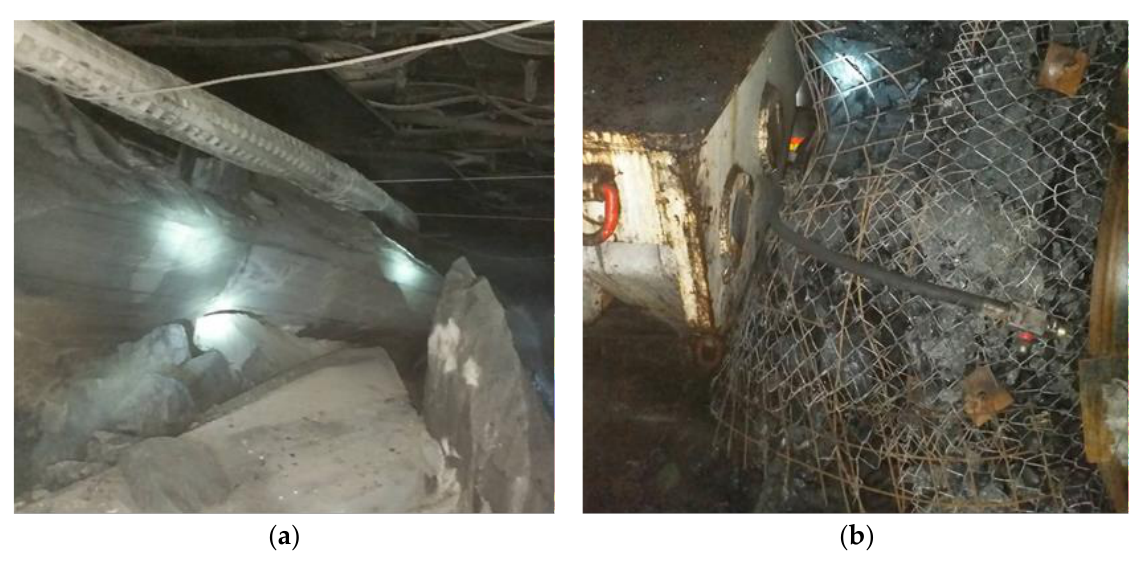
Figure 2. 31,105 ground pressure behavior during final mining retracement of working face: ( a ) roof fall of working face; ( b ) the retracement roadway is severely deformed.